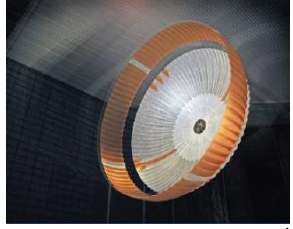
Figure 9. A typical Disk-Gap-Band Parachute (Cruz et al., 2013)